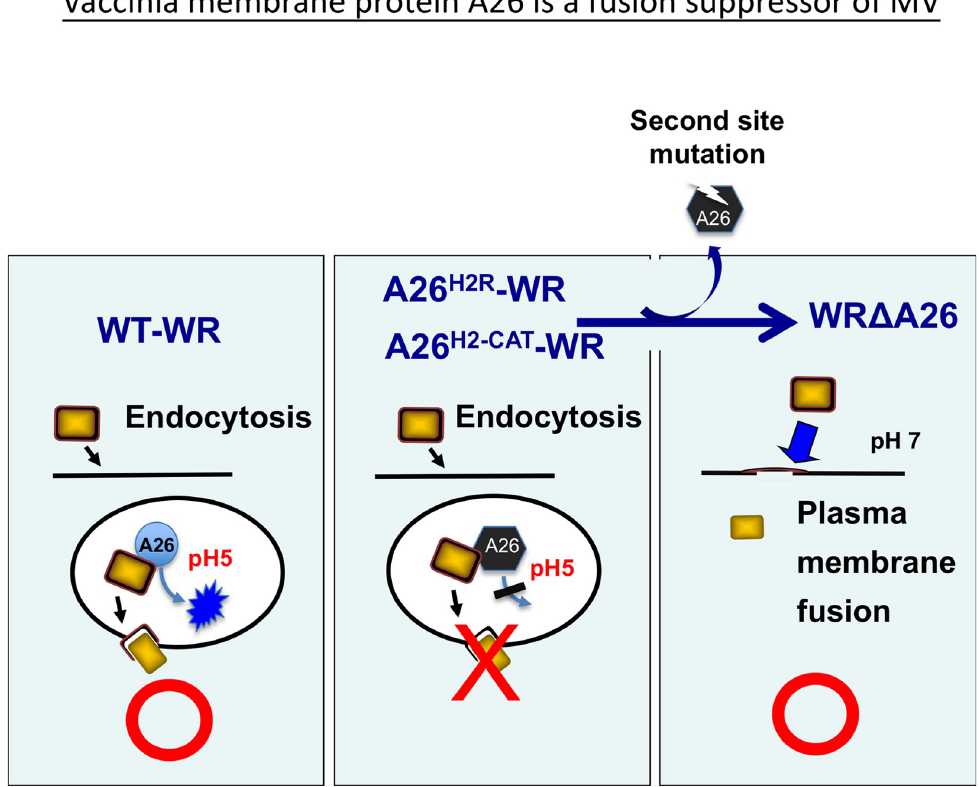
Fig 8. Vaccinia virus membrane protein A26 is a fusion suppressor of MV. Data presented in this study reveal an important role for A26 protein in endocytic entry of the WR strain of vaccinia MV. Low pH in endosomes triggers conformational changes of wild type A26 protein to allow membrane fusion within vesicles. However, when mutant A26 protein, such as A26 H2R or A26 H2-CAT , loses the ability to execute conformational changes at low pH, it becomes a constitutive suppressor that blocks virus membrane fusion, resulting in significant loss of mature virus infectivity. Subsequent generation of the second-site mutations then leads to truncation of A26 protein so the resulting revertant viruses acquire a phenotype similar to that of WR Δ A26 virus and initiate virus fusion with the plasma membrane at neutral pH to recover MV infectivity.